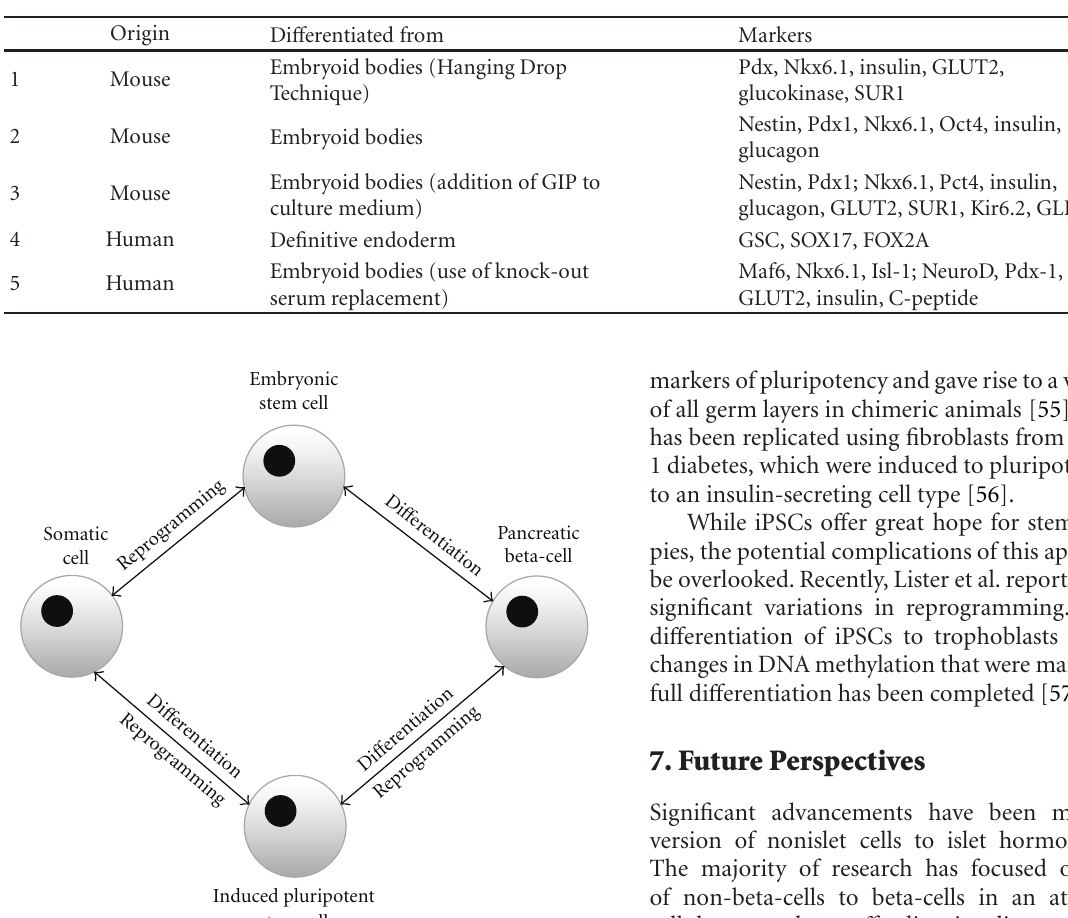
Table 1: Summary of approaches used to di ff erentiate embryonic stem cells to insulin-producing cells.